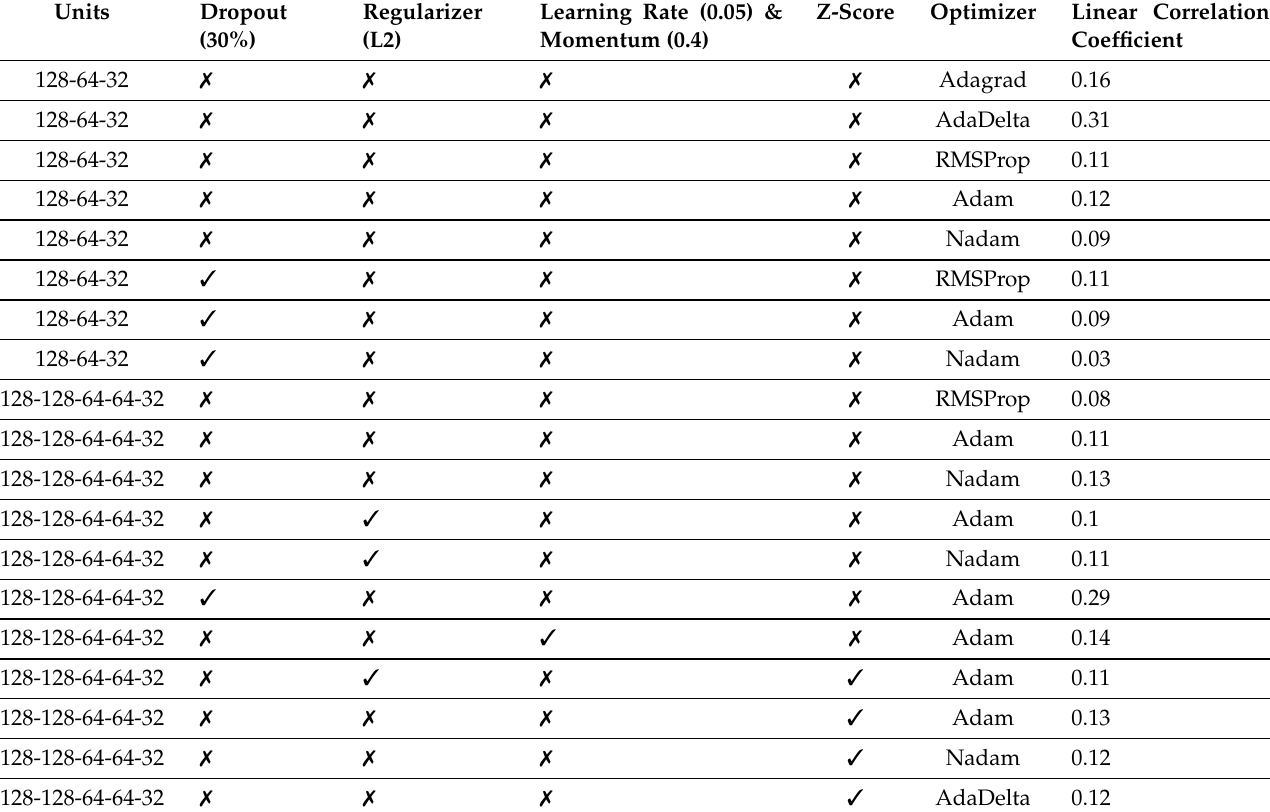
Table 3. Performance on validation data by architecture.